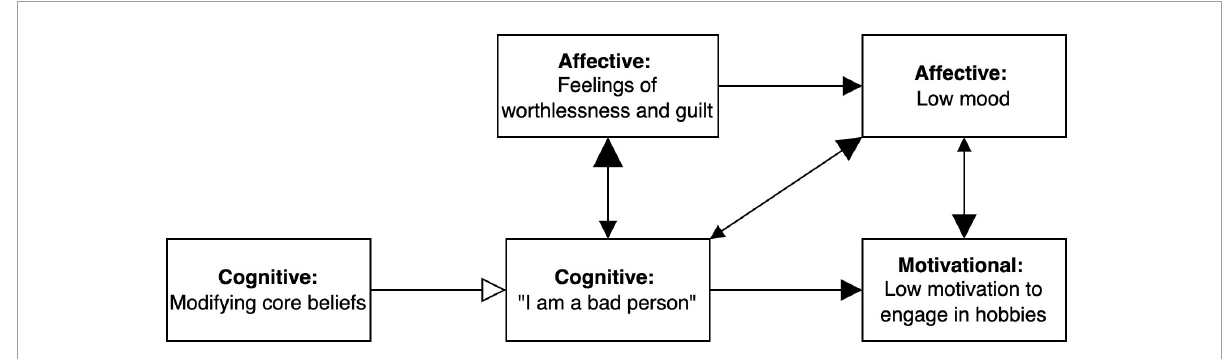
FIGURE1 Example of network model for a specific client. Extended evolutionary meta-model (EEMM) dimensions represented by each node are bolded. Size of the arrowheads indicates hypothesized strength of the relationship (bigger arrowheads = stronger correlation), and opacity reflects direction of the relationship (opaque = positive/excitatory, transparent =